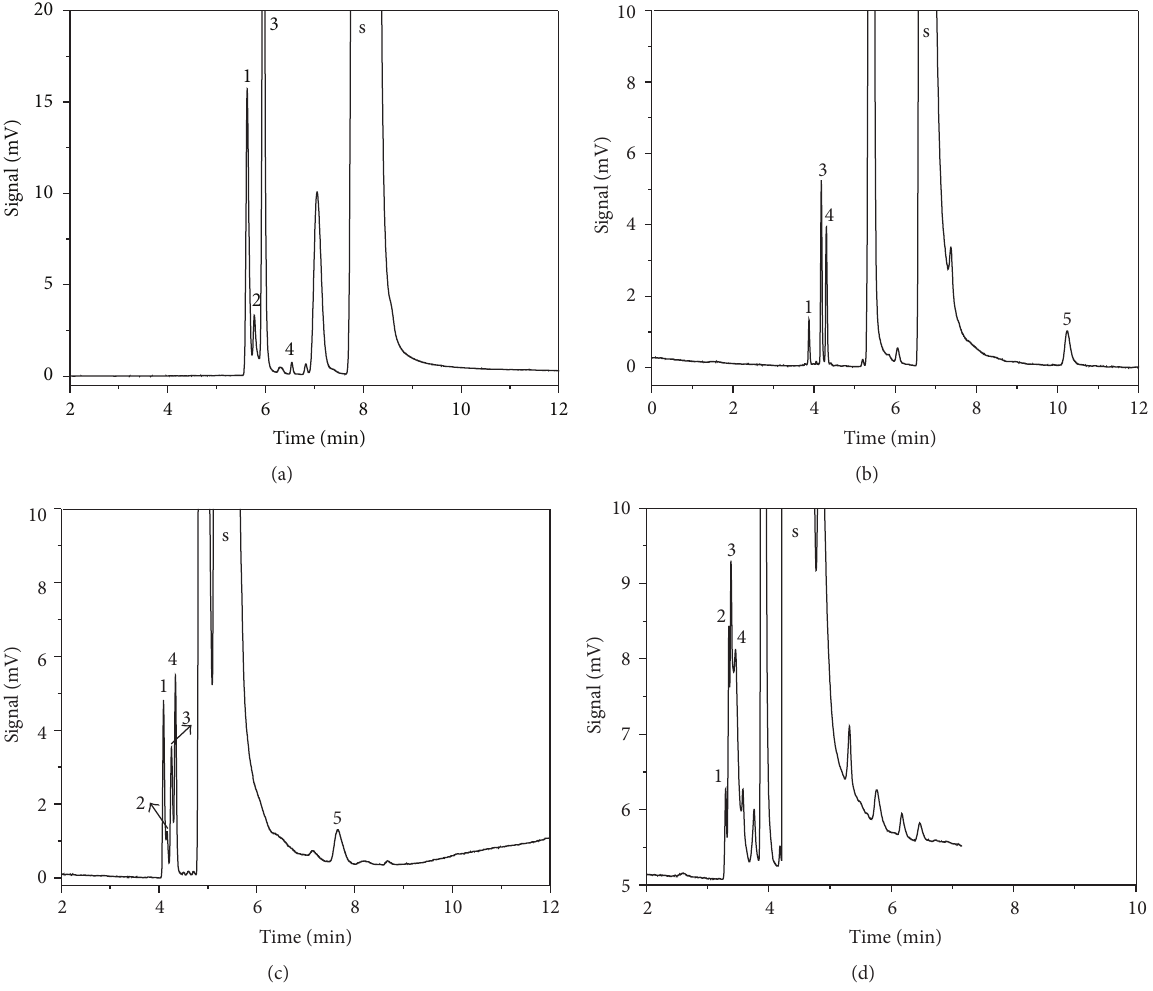
Figure 2: Effect of initial temperature and carrier gas flow rate of (a) 40 ∘ C and 10mL ⋅ min −1 , (b) 40 ∘ C and 20 mL ⋅ min −1 , (c) 50 ∘ C and 20 mL ⋅ min −1 , and (d) 50 ∘ C and 30 mL ⋅ min −1 . Peaks: solvent (s), dimethylamine ( 1 ), allyldimethylamine ( 2 ), allyl chloride ( 3 ), allyl aldehyde ( 4 ), and allyl alcohol ( 5 ).